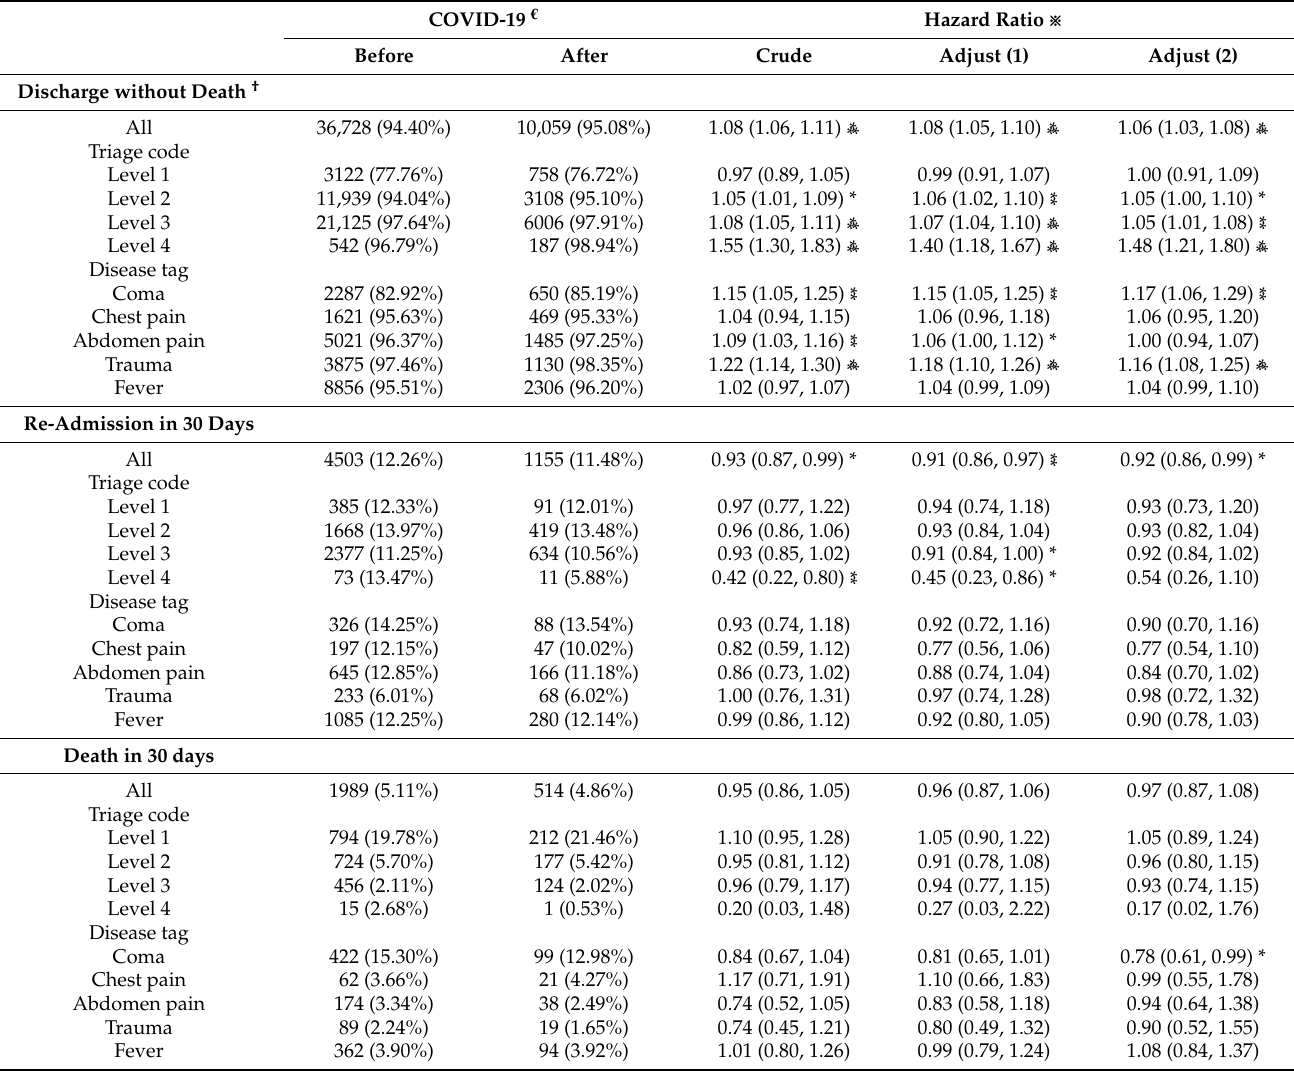
(95% CI: 0.94, 1.44) in admission], respectively. Of note, non-admitted visits with chest pain exhibited increased mortality after the start of the COVID-19 pandemic, which seemed to be an independent effect after adjusting for all variables [adjusting HR-2: 5.40 (95% CI: 1.28, 22.84)]. Therefore, we performed the subgroup analysis in fever and chest pain visits. Visits with fever after the start of COVID-19 presented higher proportions in triage level 2 and comorbidities, both for admitted and non-admitted visits. Although a significant difference in inflammatory markers was present in non-admitted visits (CRP, p -value = 0.003; WBC, p -value < 0.001), the actual difference may not have clinical importance. Non-admitted visits with chest pain seemed less critical after the start of COVID-19 pandemic, with less proportion in triage level 1 and 2, and less disease comorbidities (data not shown). Table 6. Prognosis of admitted visits before and after the start of the COVID-19 pandemic. COVID-19 € Hazard Ratio ※ Before After Crude Adjust (1) Adjust